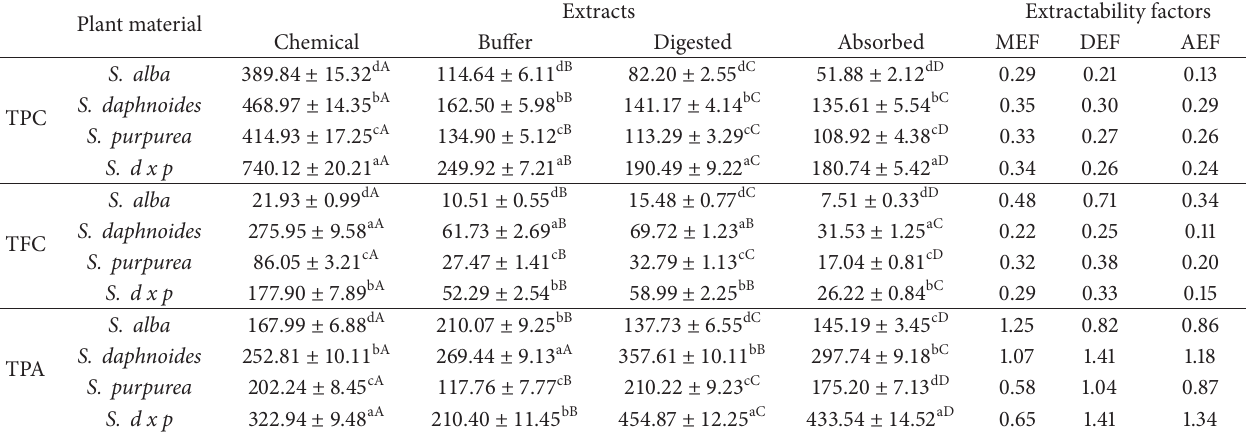
Table 1: Comparison of content and extractability factors of phenolic compounds. Plant